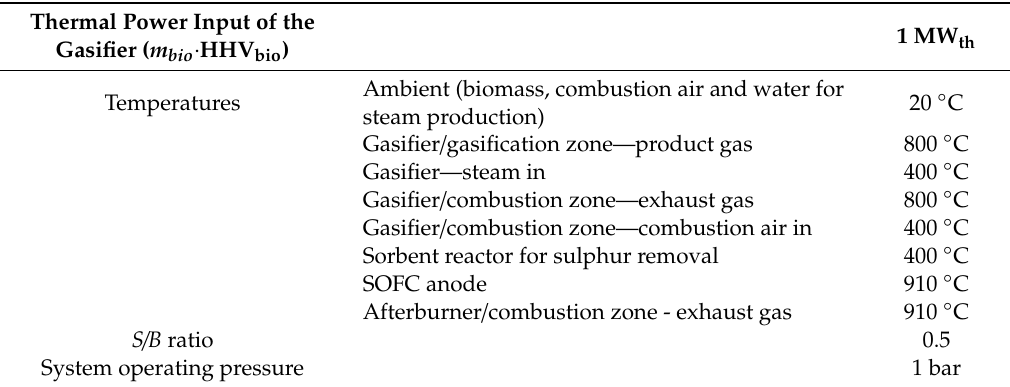
Table 4. The operating conditions of the system.